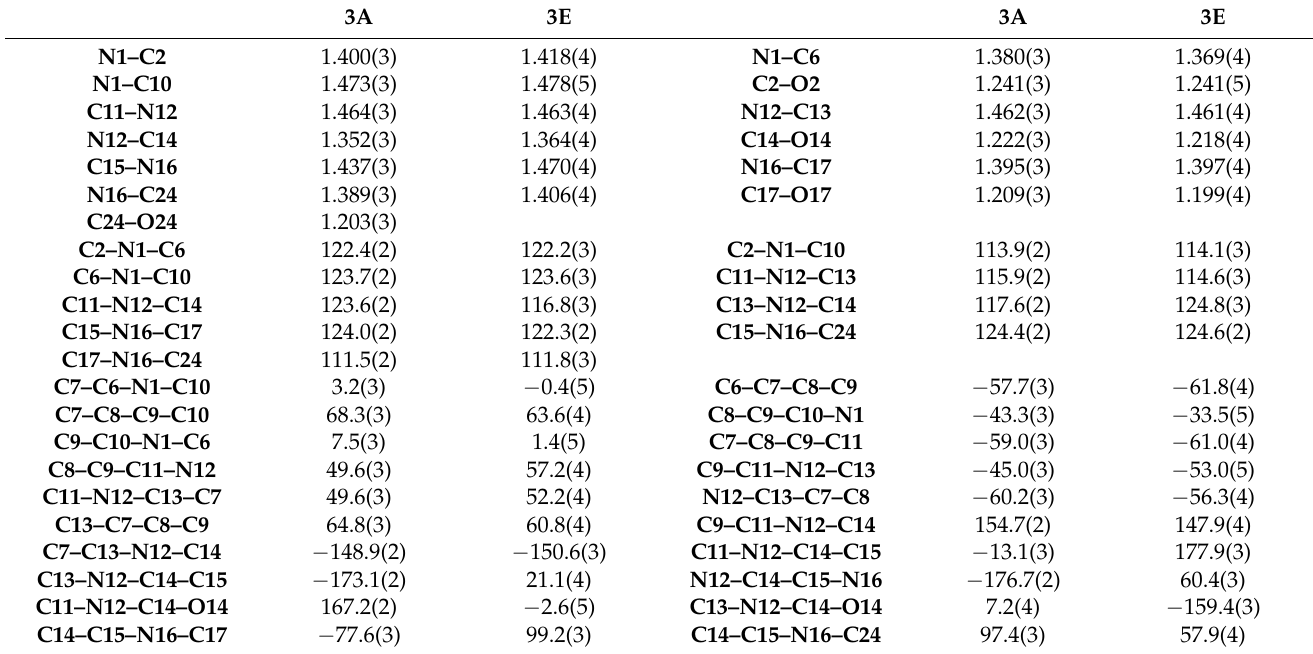
Figure 4. A perspective view of the molecule 3E. Ellipsoids are drawn at the 50% probability level, hydrogen atoms are represented by spheres of arbitrary radii. Table 3. Relevant geometric parameters (Å, ◦ ) with s.u.’s in